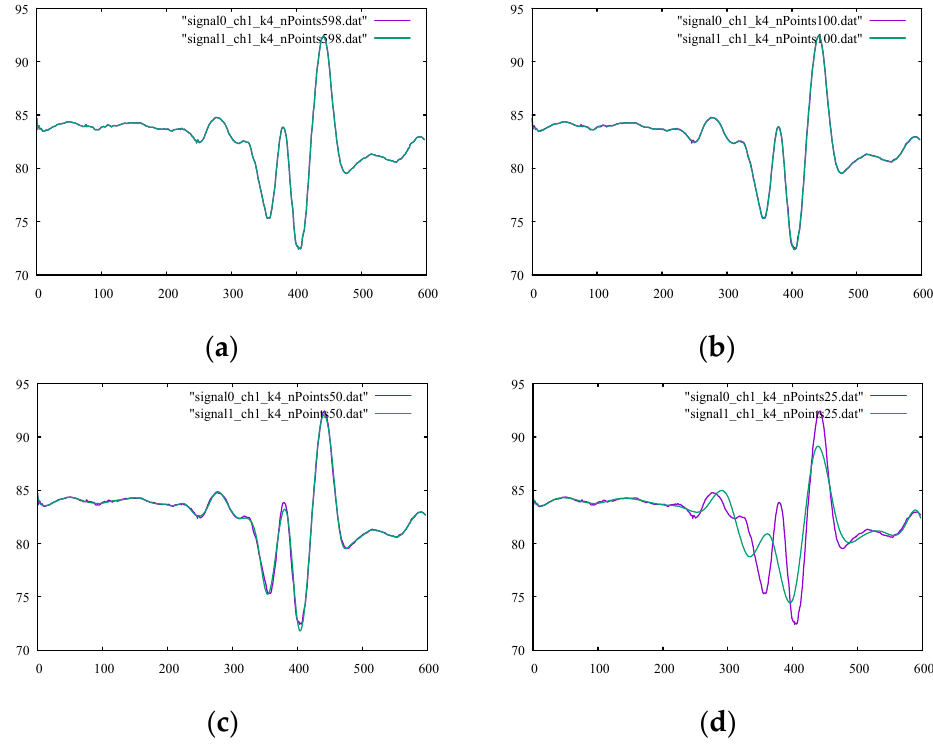
Figure 8. Original noisy motion signal from channel 1 of the root-joint of the kicking character versus